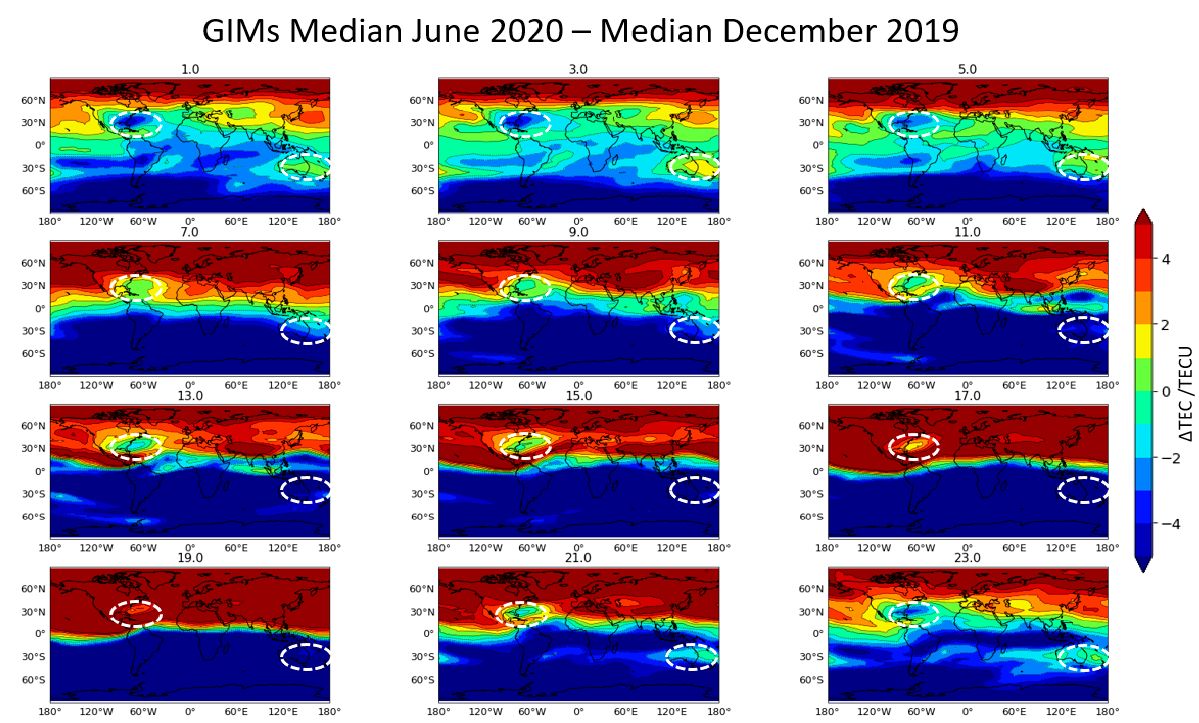
Figure 8. The differential GIM VTEC data ( a , b ), NN model predictions ( c , d ), and the NTCM predictions ( e , f ) for the LSA in 2020 and HSA in 2015. The NWA is highlighted with the red dashed circles.